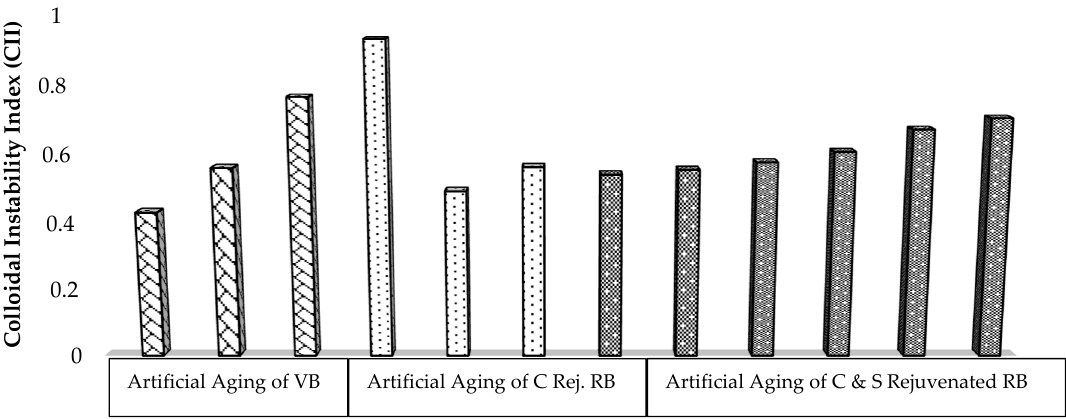
Figure 4. Effect of rejuvenation and aging on colloidal instability index (CII) of binders.